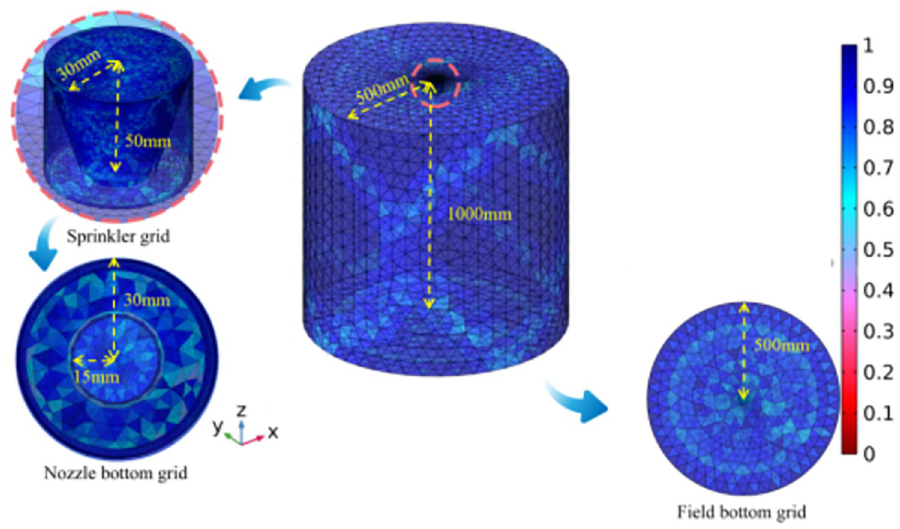
Fig 4. Model drawing of spiral nozzle.